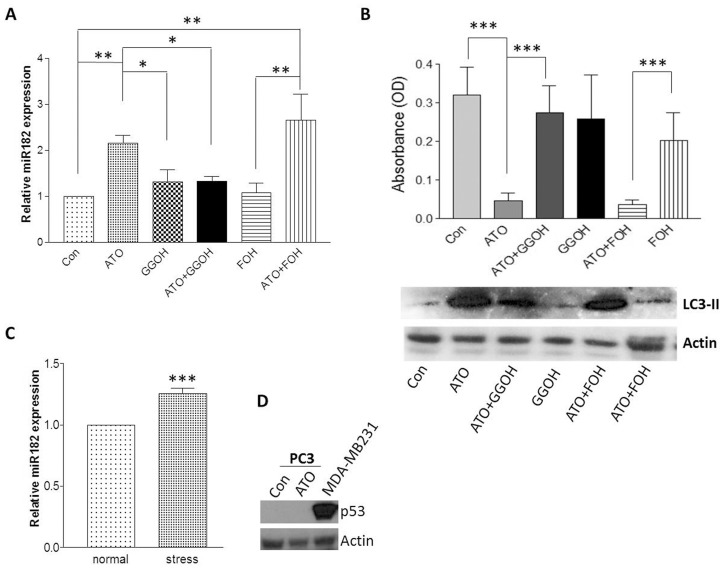
Geranylgeraniol co-treatment reversed ATO effect on miR-182 expression.(A) PC3 cells were treated with 5 µM ATO for 48 h in the presence and absence of metabolites including geranylgeraniol (10 µM) and farnesol (10 µM), miR182 expression was then detected by qRT-PCR. (B) PC3 cells were treated with 5 µM ATO for 2 or 4 days in the presence and absence of geranylgeraniol (10 µM) and farnesol (10 µM), cell proliferation (4 day treatment) was evaluated by MTT assay and LC3-II expression (2 day treatment) was examined by western blot. (C) PC3 cells were cultured in normal growth medium (10% FBS) overnight, and were then stressed by culturing in low serum medium (1% FBS) for 48 h, followed by quantitation of miR-182 expression by qRT-PCR. (D) p53 expression was examined by western blot analysis in PC3 cells, MDA-MB-231 breast cancer cells served as a positive control for p53 expression. For all bar graphs, data are expressed as Mean ± SD; for qRT-PCR analyses, n = 3; for MTT assay, n = 8; *p<0.05, **p<0.01, ***p<0.001.